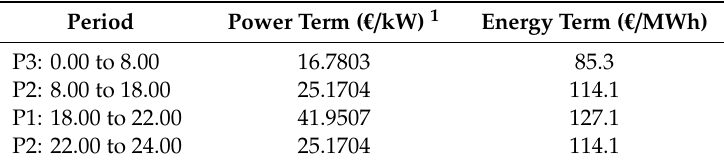
Table 5. Electrical tari ff [56].